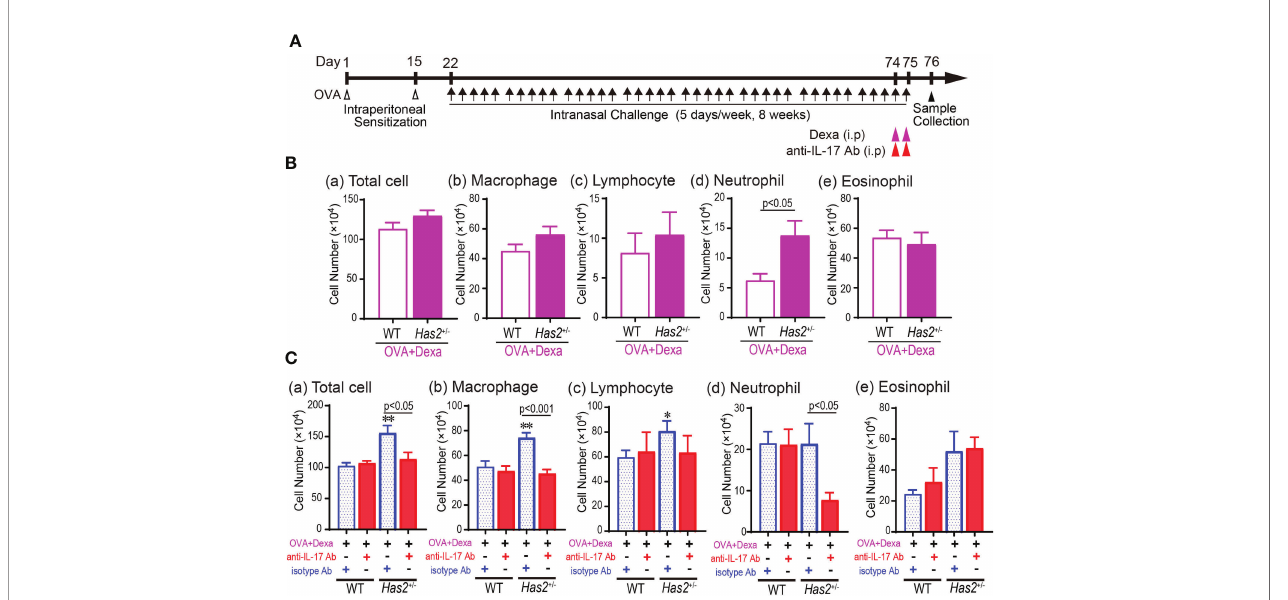
FIGURE 6 | Combined treatment with dexamethasone and anti-IL-17A Ab is effective for steroid-insensitive airway in fl ammation in Has2 +/ − mice. (A) Schematic illustration of the experimental design for steroid insensitivity and neutralization experiment. (B) BALF cytology of each indicated cell type after the dexamethasone treatment from WT-OVA mice and Has2 +/ − -OVA mice ( n = 8 – 11). (C) BALF cytology of each indicated cell type after a combined treatment with dexamethasone and anti-IL-17A Ab from WT-OVA and Has2 +/ − -OVA mice ( n = 7 – 11). All samples are obtained 24 h after the fi nal challenge with OVA. Statistical signi fi cance was determined using the Mann – Whitney U test. * P < 0.05 and ** P < 0.01 relative to WT-OVA-Dexa mice. Horizontal bars indicate direct statistical comparisons between WT-OVA and Has2 +/ − -OVA mice. Dexa, dexamethasone; i.p., intraperitoneal injection; NS, not signi fi